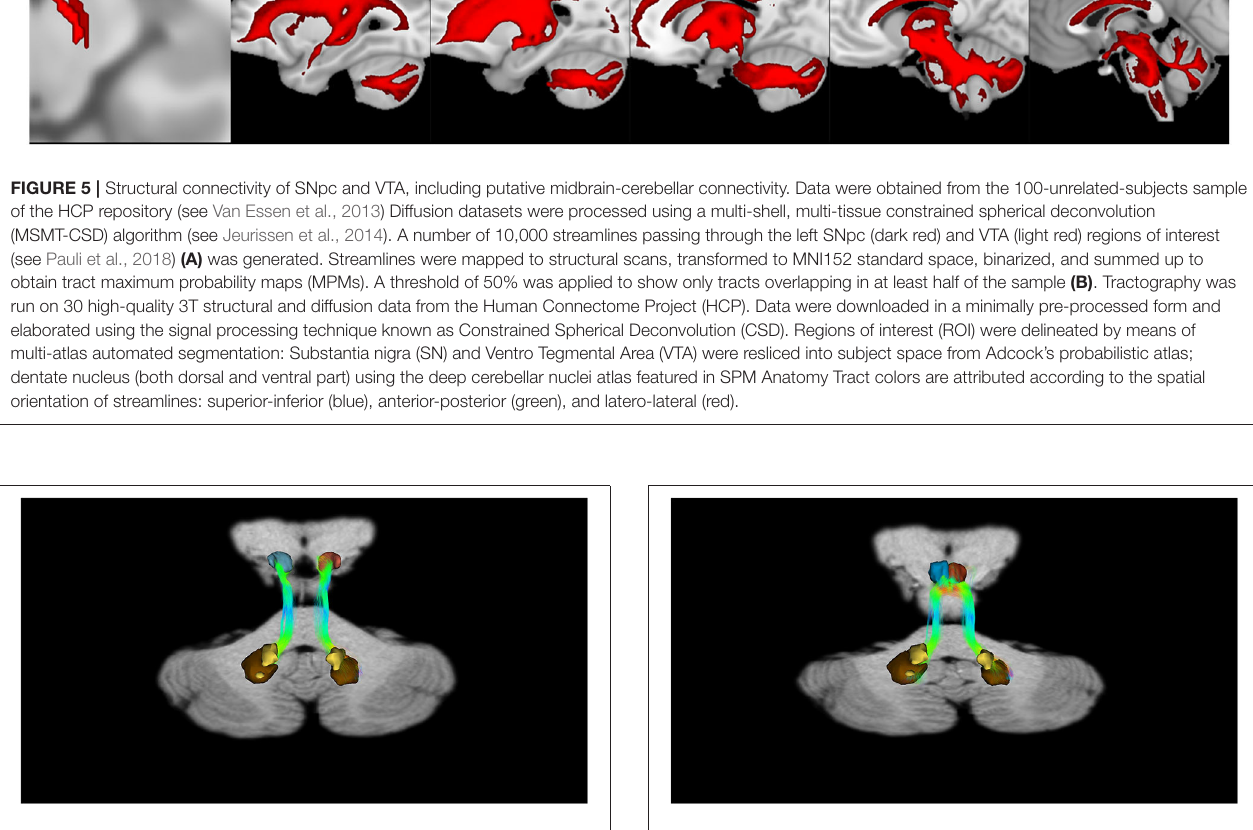
FIGURE 6 | Dentate-nigral interconnections. Coronal view shows the interconnections between the right dentate nucleus and the ipsilateral SN, and the left dentate nucleus and the ipsilateral SN. The fibers exited the cerebellum via the right and left superior cerebellar peduncles.